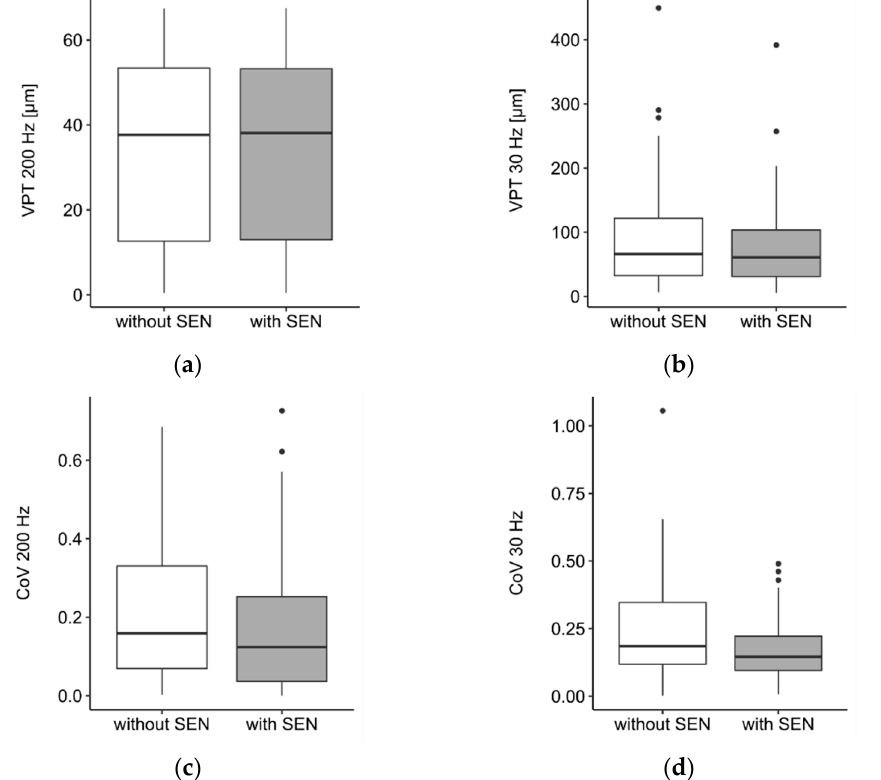
Figure 2. Boxplots showing vibration perception thresholds (VPT) at 200 Hz ( a ) and 30 Hz ( b ) and coefficient of variation (CoV) at 200 Hz ( c ) and 30 Hz ( d ) with and without subliminal electrical noise stimulation (SEN). Extreme values above 1.5 of the interquartile range are shown as dots.